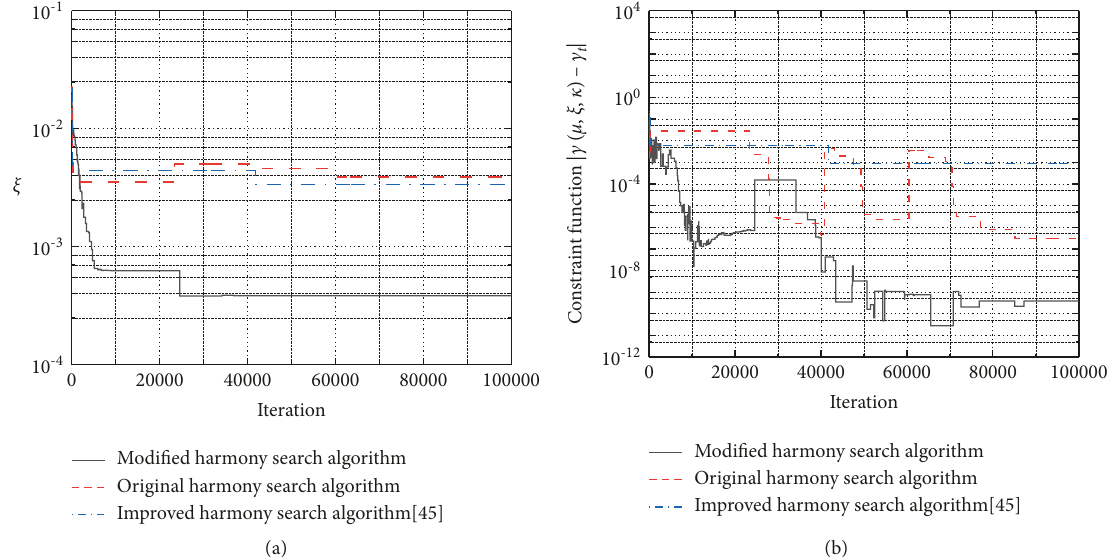
Figure 5: The variation trends of key indices during the optimization process for case 1. (a) The nominal damping ratio ξ . (b) The constraint function | c ( μ , ξ , κ ) − c t | .